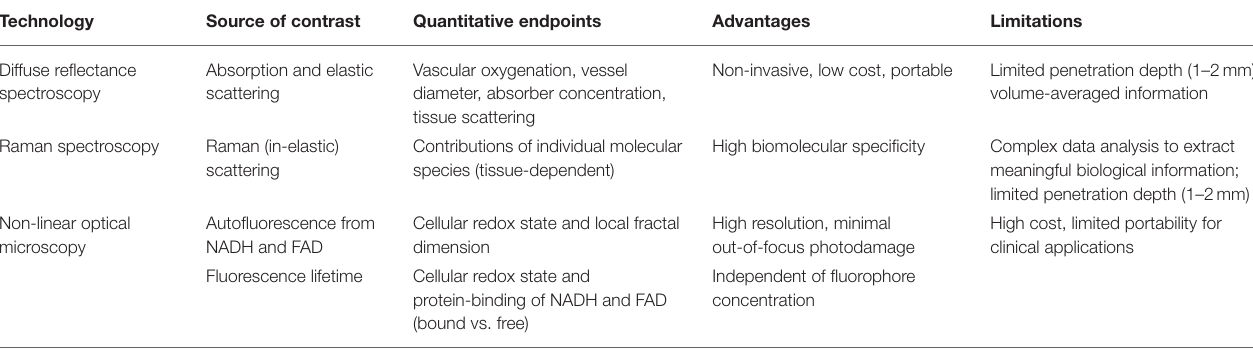
TABLE 1 | Comparison of optical microscopy and spectroscopy techniques for investigating radiation biology. Technology Source of contrast Quantitative endpoints